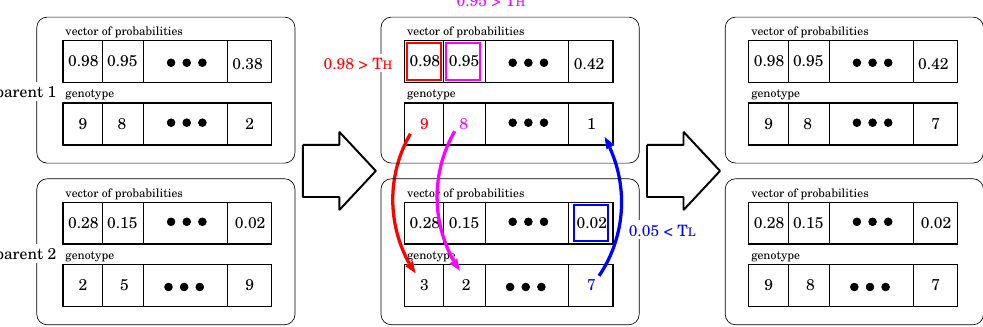
Figure 3. An application example of the crossover operator of the evolutionary algorithm evolving developmental timing